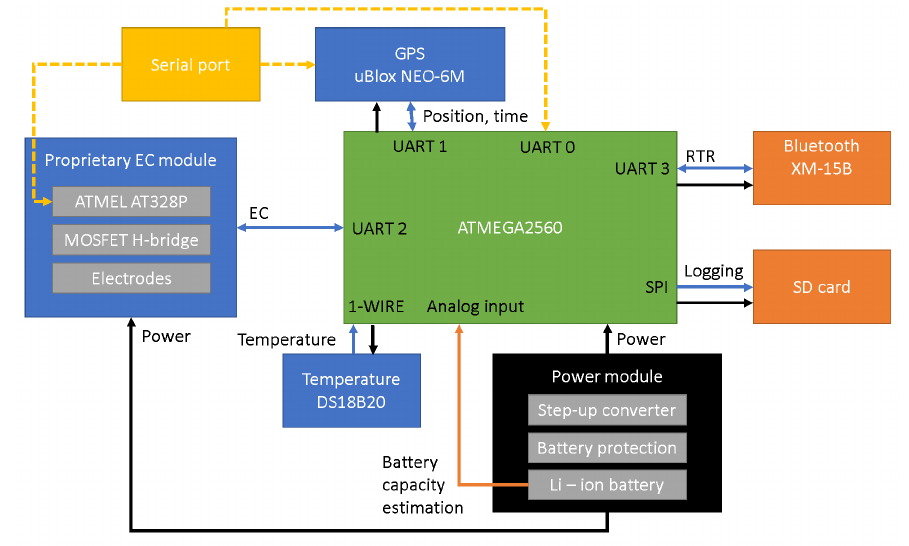
Figure 4. The schematic representation of the Arduino based probe